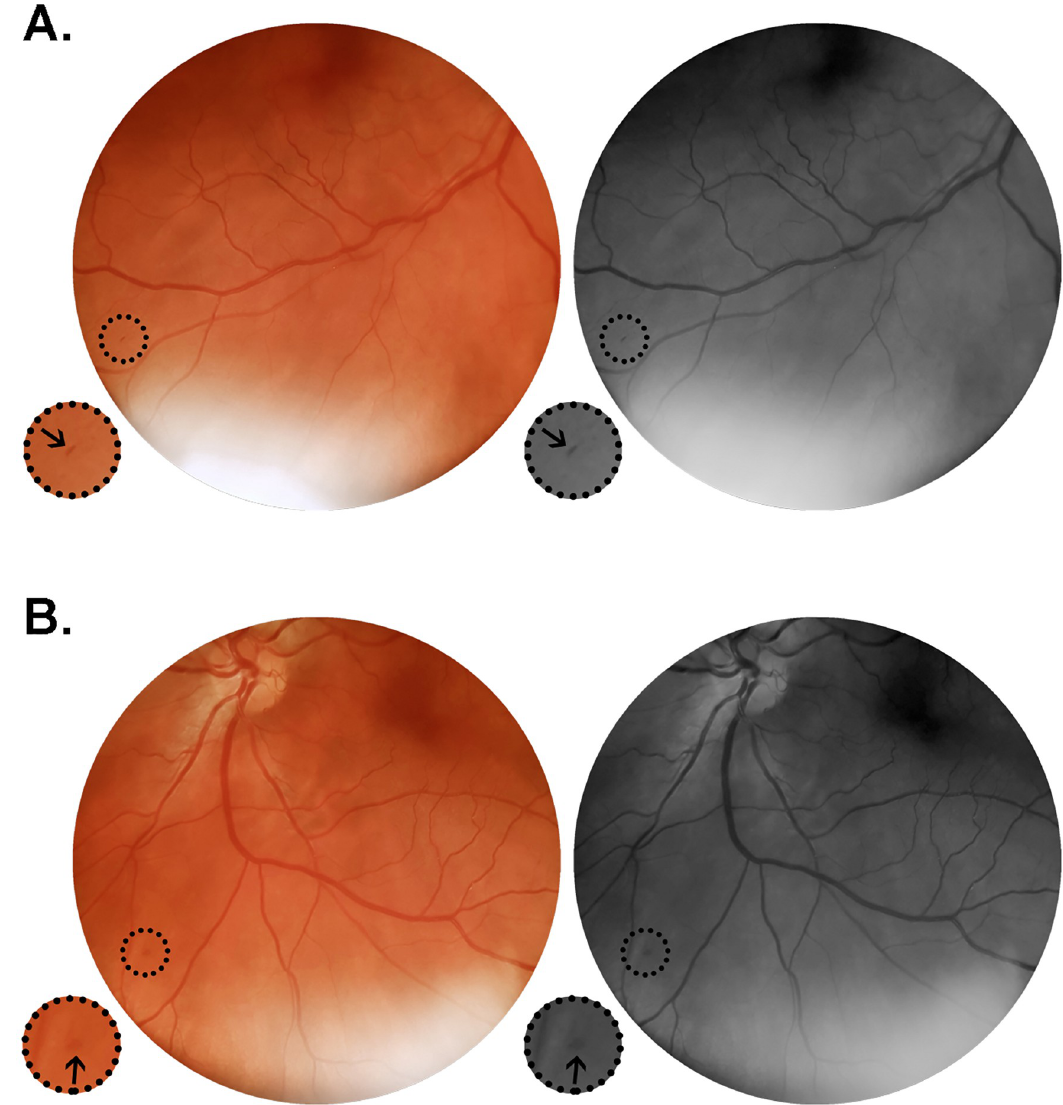
Fig 3. Color and red-free retinal photographs from patient #19 (G.C.X.). Images acquired on day 12 from symptoms onset, from a 49 year-old man in regular treatment for arterial hypertension, admitted on the eight day after onset of fever, cough, myalgia and progressive dyspnea. Lung CT on admission showed typical viral pneumonia findings extending through 25–50% of the parenchyma. The patient evolved to a severe phenotype of the disease. (A) Right retina presenting with isolated microhemorrhage at the periphery close to the inferior temporal vasculature. (B) Left retina showing isolated microhemorrhage at the inferior nasal retinal quadrant. Insets represent delimited areas with 2x magnification. (Table 2). Genetic factors may have also influenced the emergence of retinal abnormalities in the three patients depicted in the presented study, in contrast to the other 22 patients who did not present any retinal changes upon careful retinographies evaluation, despite the severe or critical disease phenotype with varied related clinical intercurrences during hospitalization. On the other hand, disease phenotype, per se, does not seem to impact the findings on fundus examination in the present study, as comparison between severe and critical patients showed no statistical significance in terms of retinal changes (Table 1).